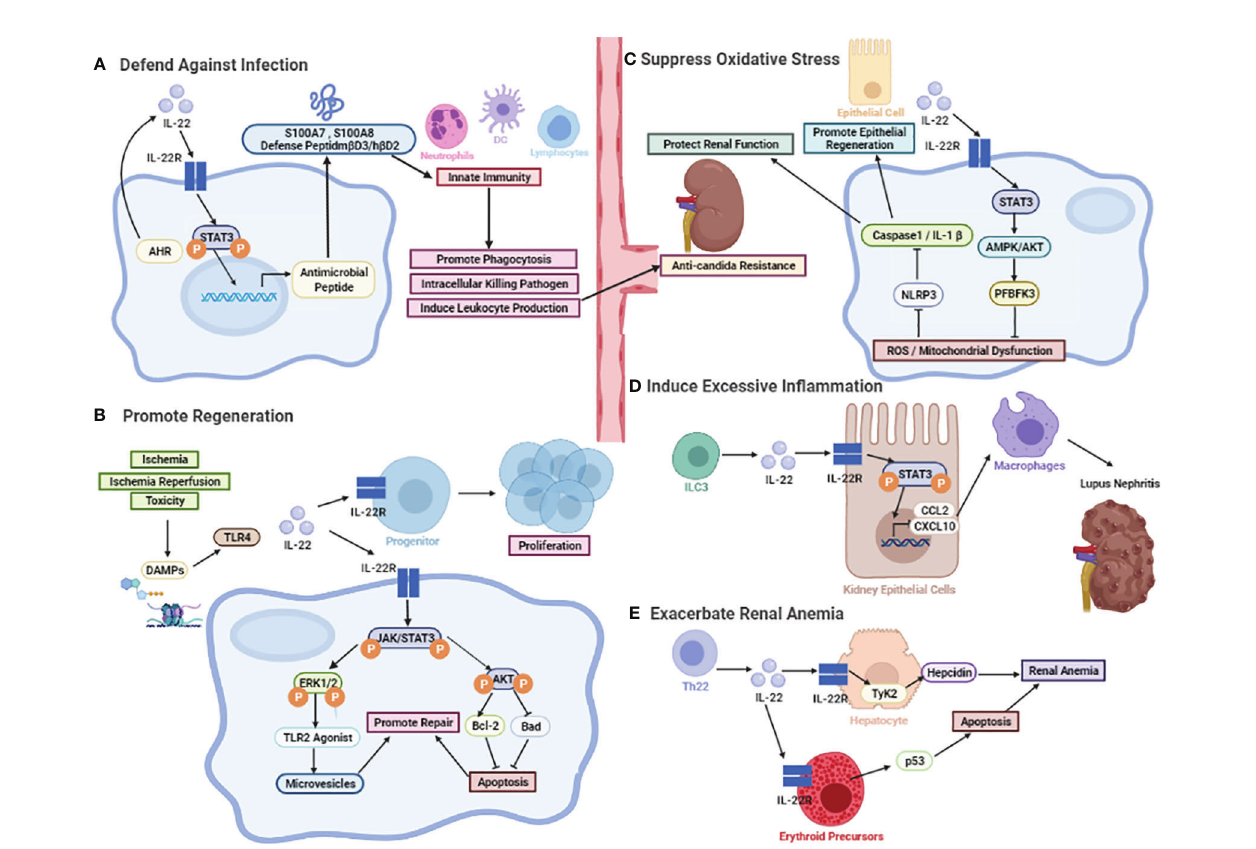
FIGURE 2 | The biological effect of IL-22. (A) The protective role against microorganisms including bacterial and fungal. The induction of various antimicrobial peptides, like psoriasis (S100A7), calgranulin-A (S100A8), calgranulin-B (S100A9), b -defensin-3 (m b D3), and lipocalin-2. (B) The protective role in promoting regeneration. IL-22-mediated regenerative function by activation of JAK-STAT3 and ERK1/2 phosphorylation. After the onset of AKI, TLR4-IL-22 signaling is a speci fi c stimulus for IL-22 induction. Other than that, activation of STAT3 and AKT can be detected after I/R, followed by an increase in Bcl-2 levels and a decrease in Bad levels. (C) The protective role in the inhibition of oxidative stress. It may promote renal repair through the active expression of renal reprogramming PFBFK3 by IL-22 mainly inducing STAT3-AMPK/AKT signaling after injury, slowing down the accumulation of reactive oxygen radical ROS production and mitochondrial dysfunction, which can further protect renal function by inhibiting the NLRP3/Caspase-1/IL-1 b signaling pathway. (D) The pathological effects in recruiting chemokines. The involvement of IL-22 in the induction of CCL2 and CXCL10, which promotes the in fi ltration of macrophages to dampen kidney in fl ammation. (E) The pathological effects in inducing chronic renal anemia. IL-22 exacerbates anemia through inducing erythropoietin apoptosis and hepcidin